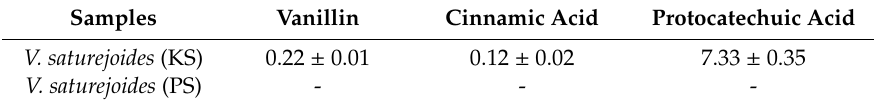
Table 4. Polyphenolic analyses of